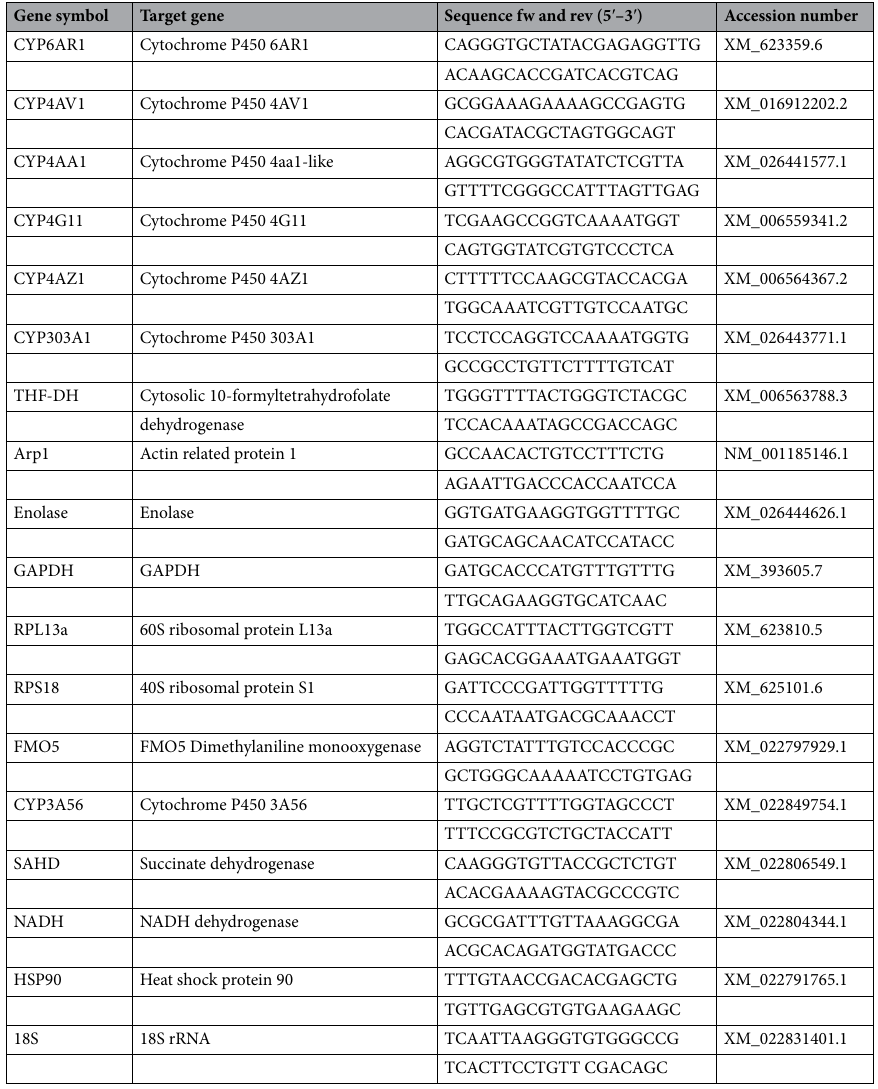
Table 1. Sequences of qPCR primers used in this